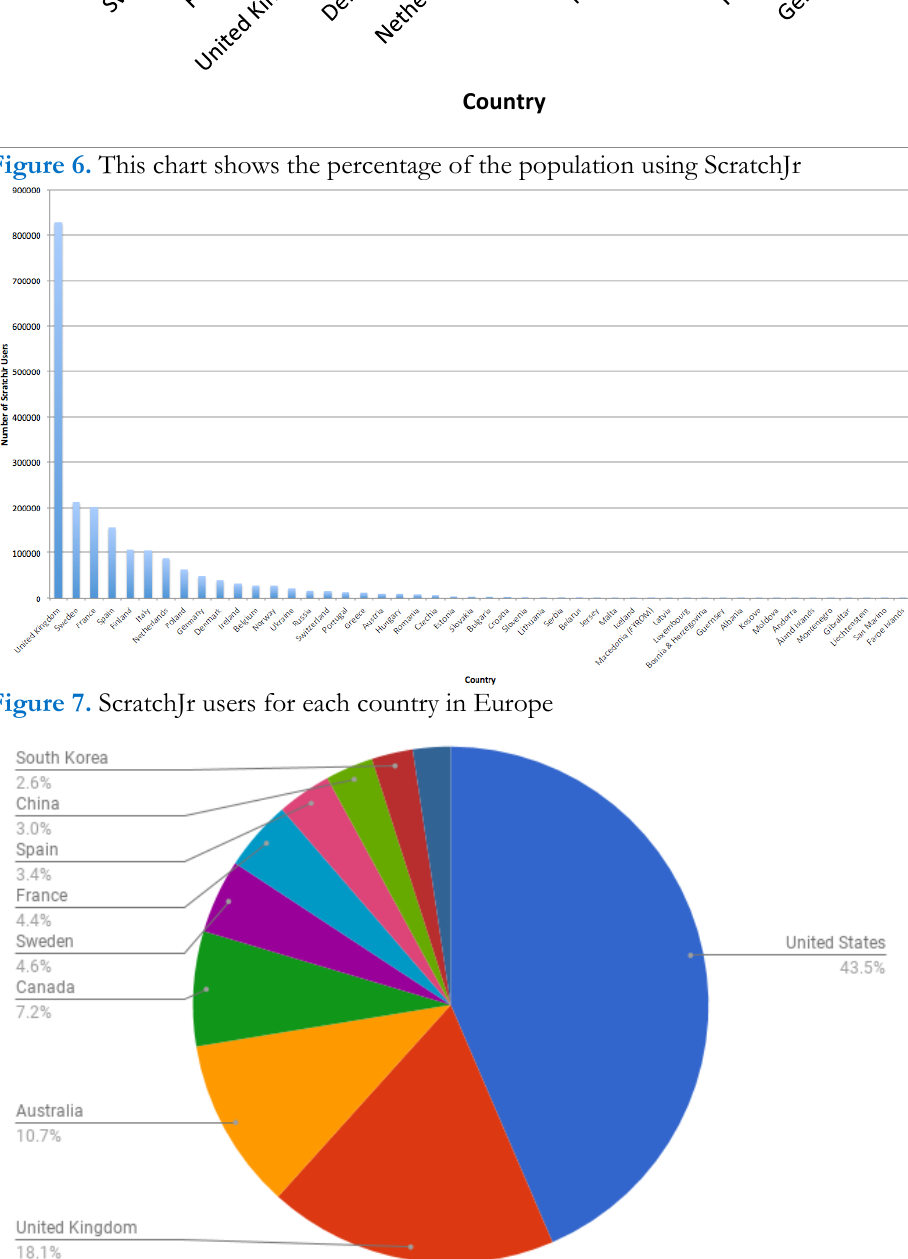
Figure 8. The top 10 countries in the world using